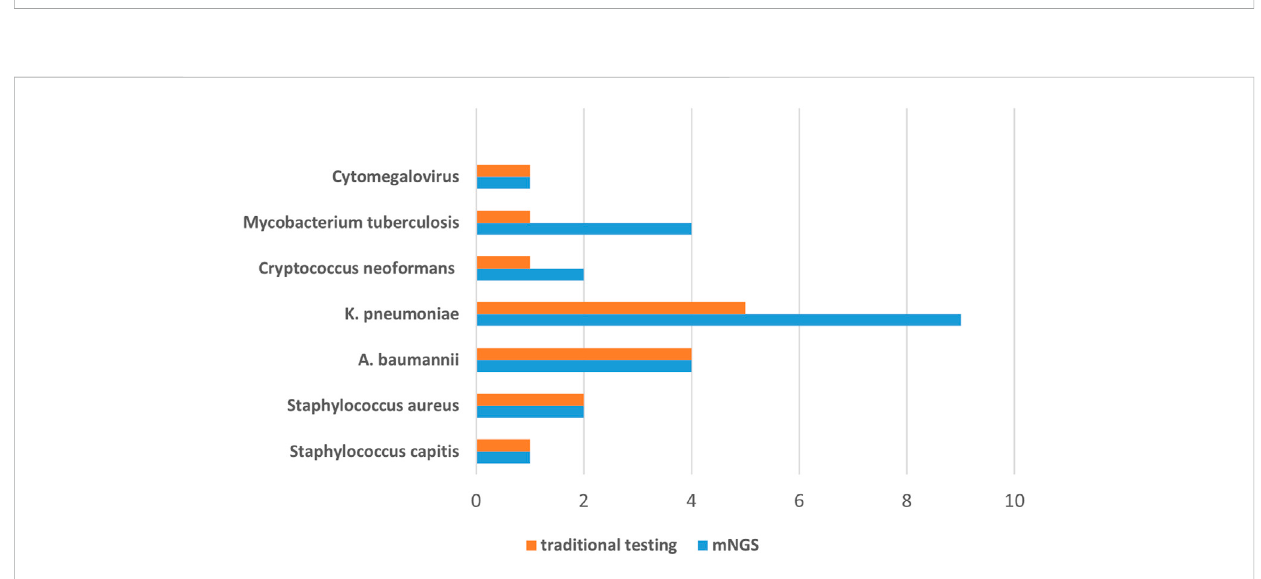
FIGURE 3 Pathogens detected by both conventional and mNGS